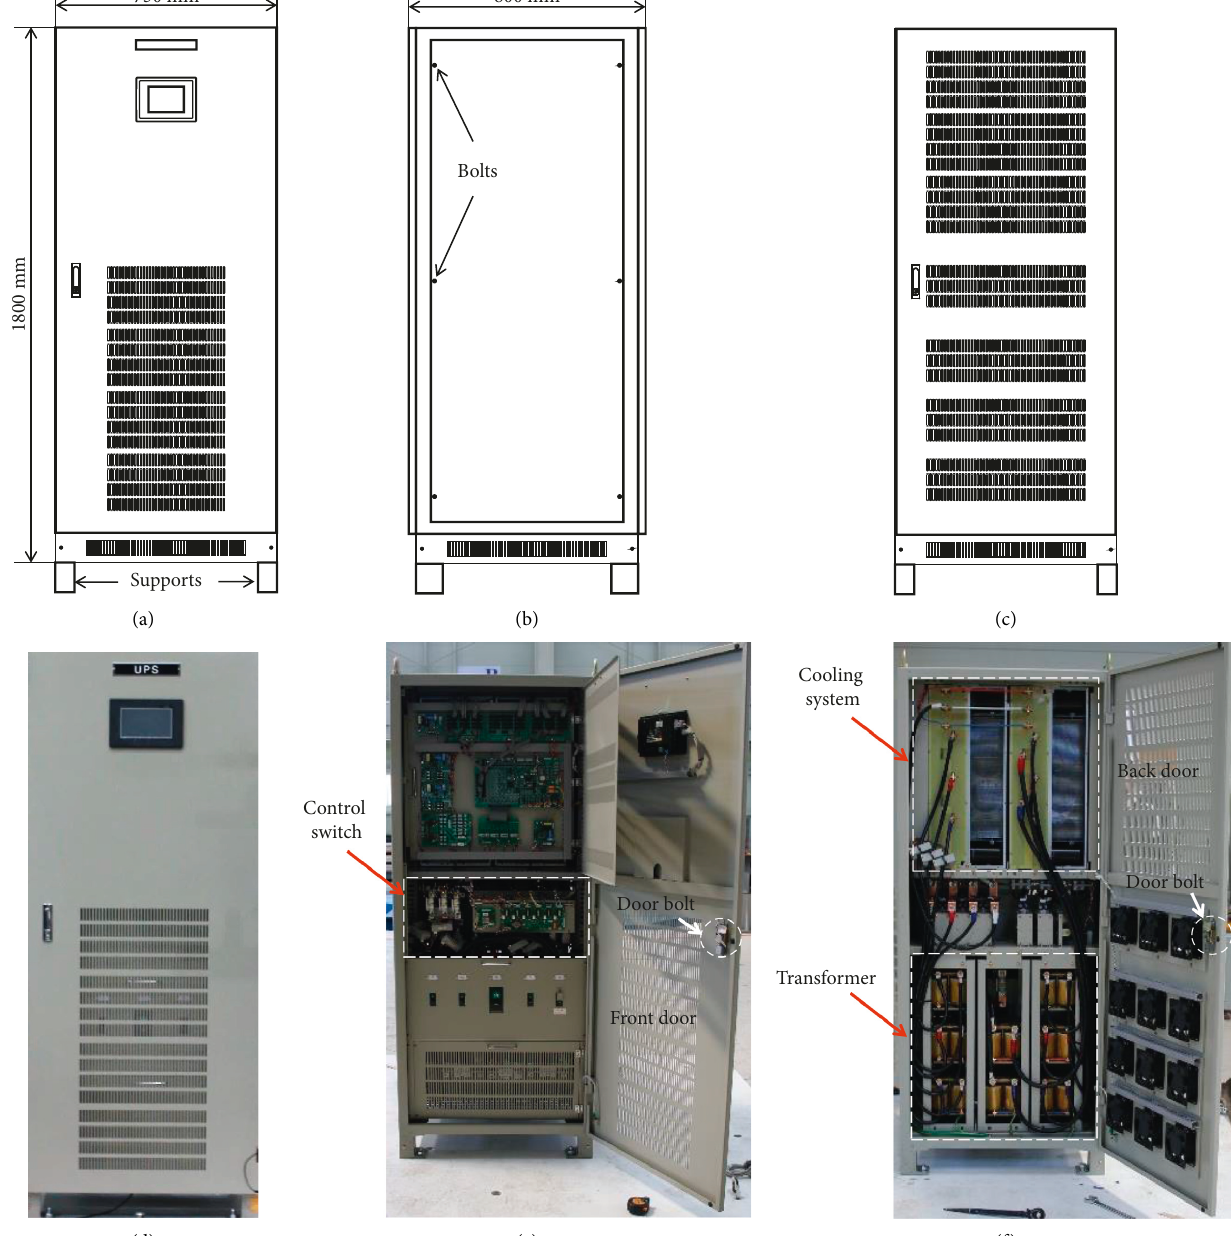
Figure 1: Details of the tested UPS. (a) Front view. (b) Side view. (c) Back view. (d) Photo of UPS: Front view (outside). (e) Photo of UPS: Front view (inside). (f) Photo of UPS: Back view